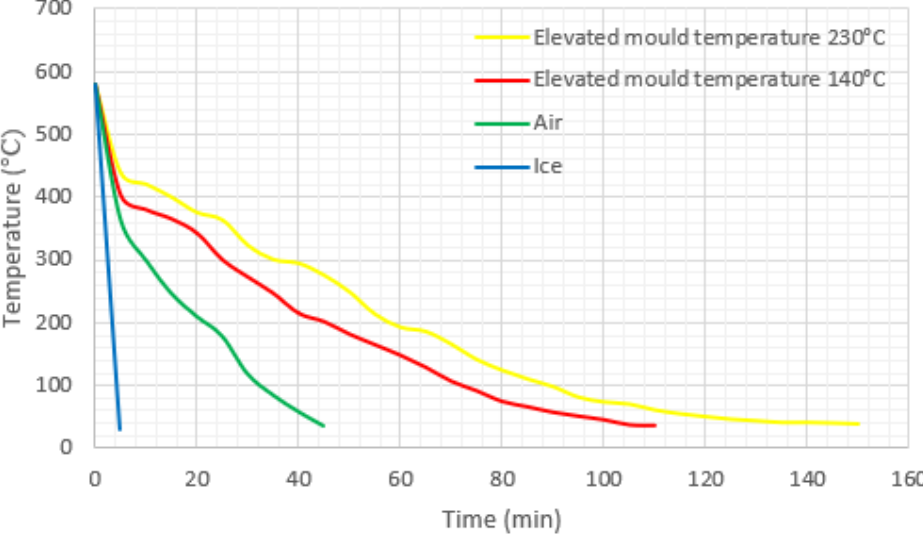
Figure 1: Cooling curves of 6xxx-series aluminium alloy under different mould